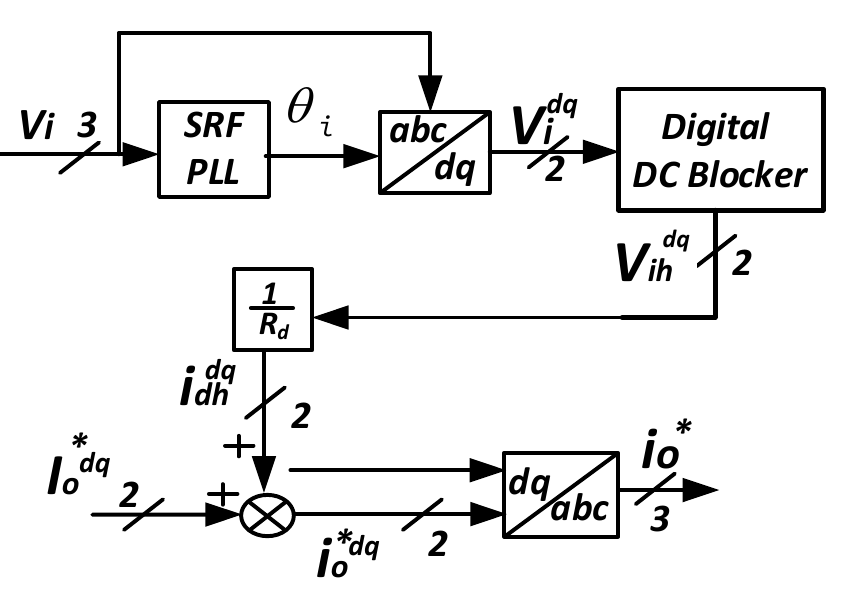
Figure 5. Input filter resonance suppression.